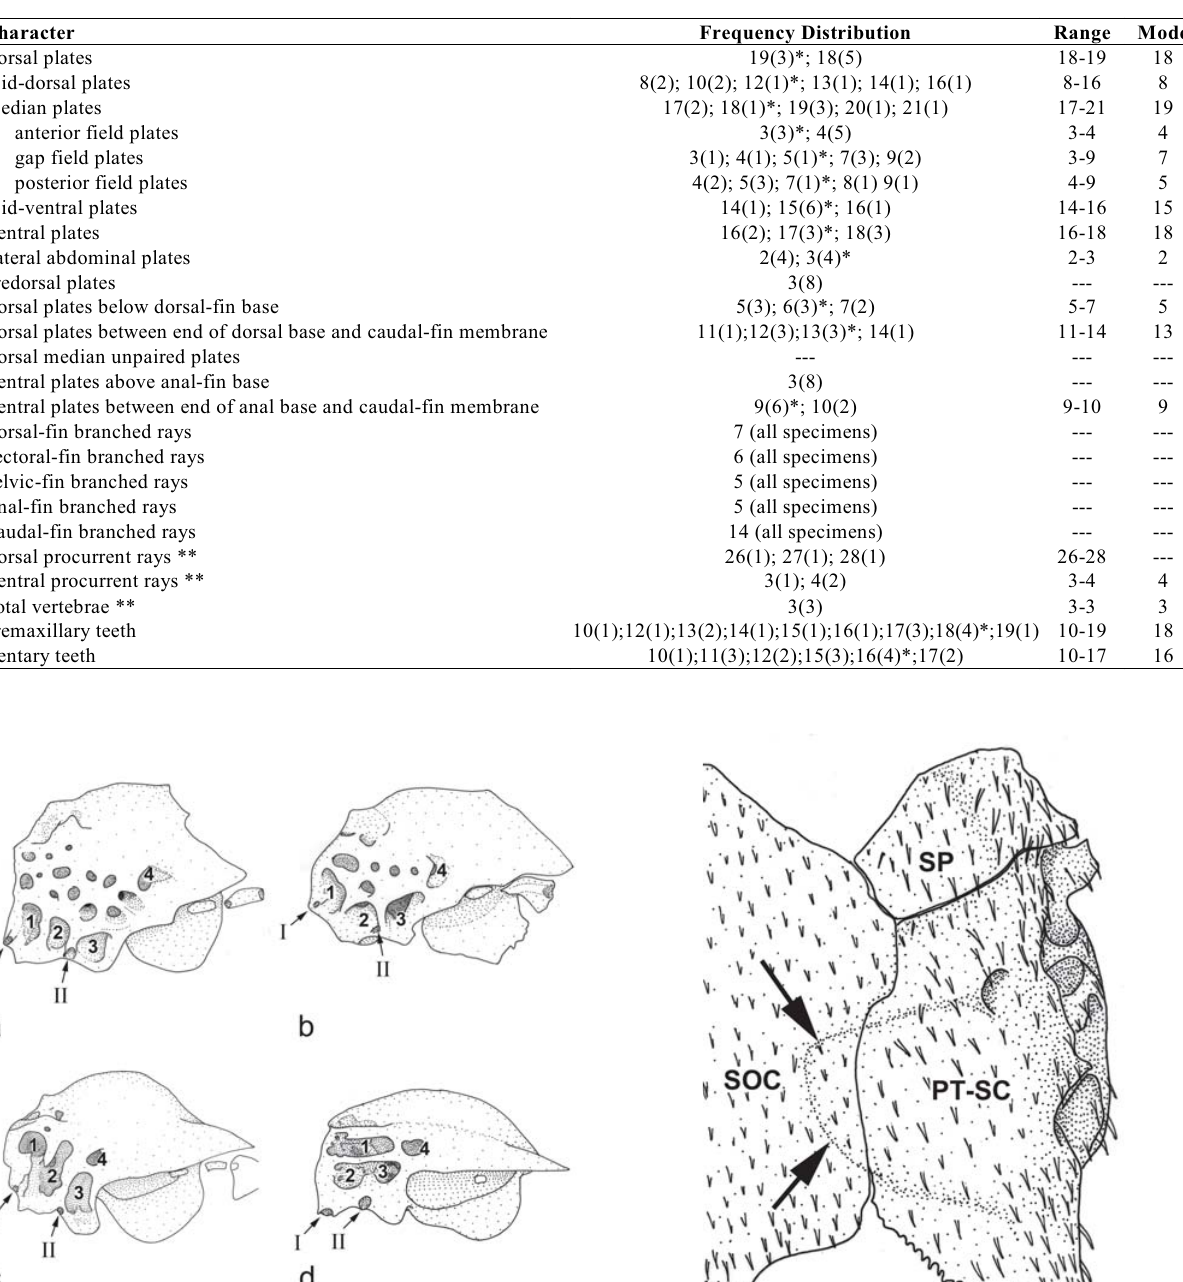
Table 2 . Frequency distribution and summary of meristics for Otothyropsis marapoama . Plate counts were made in 8 speci- mens stained with alizarin red solution . Holotype values are marked with an asterisk. Meristics marked with double asterisks were counted in c&s specimens only.